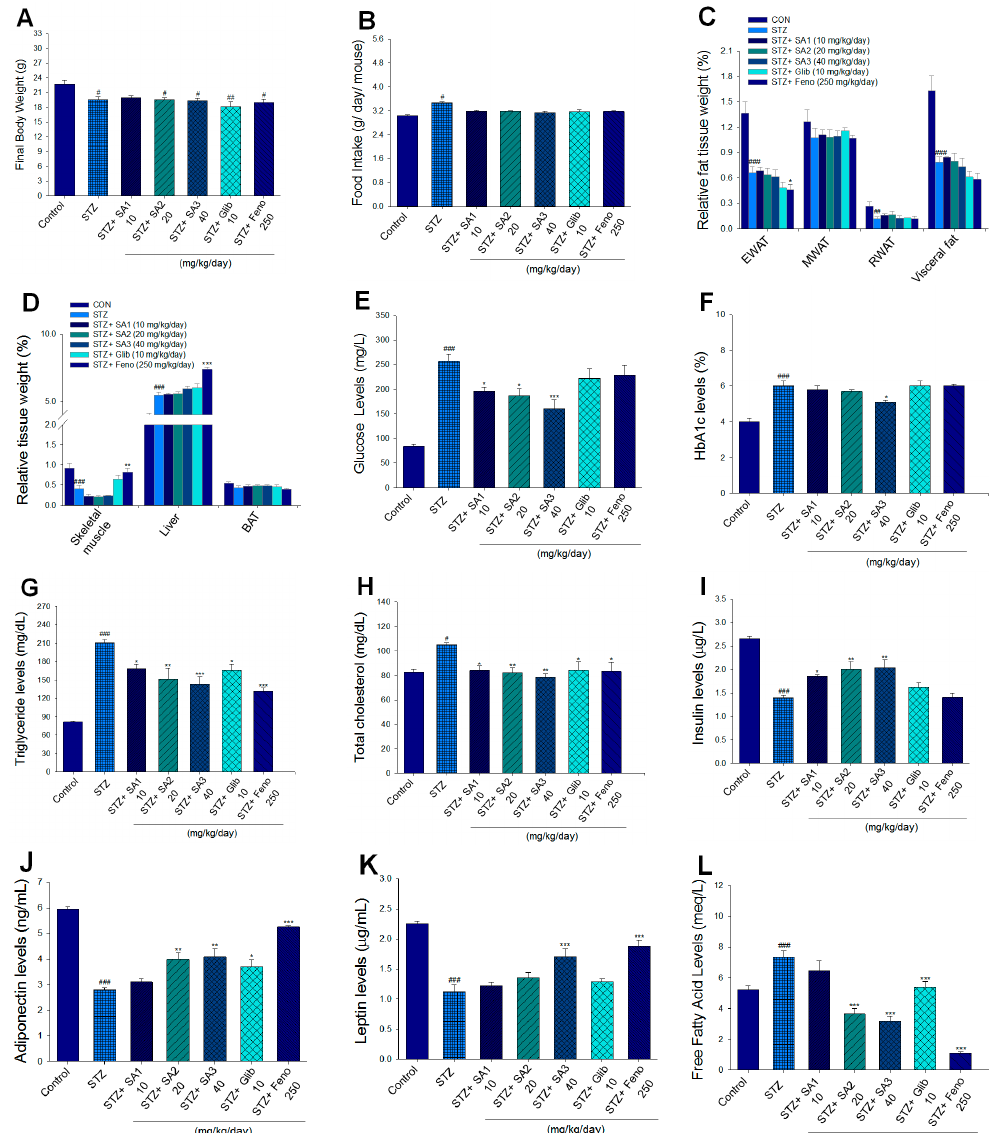
Figure 3. Effects of sulphurenic acid (SA) on ( A ) final body weight, ( B ) food intake over 3-week treatment, ( C ) relative fat tissue weight, ( D ) relative tissue weight, ( E ) blood glucose levels, ( F ) blood glycated hemoglobin (HbA1C) levels, ( G ) triglyceride levels, ( H ) total cholesterol levels, ( I ) insulin levels, ( J ) adiponectin levels, ( K ) leptin levels, and ( L ) free fatty acid levels in